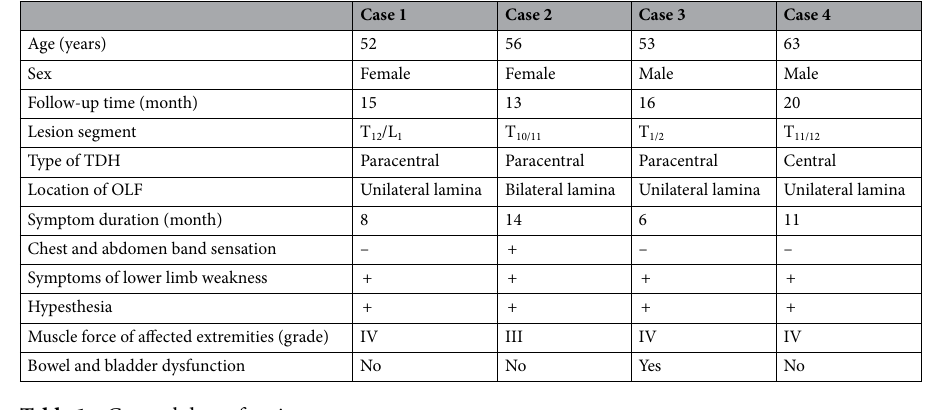
Table 1. General data of